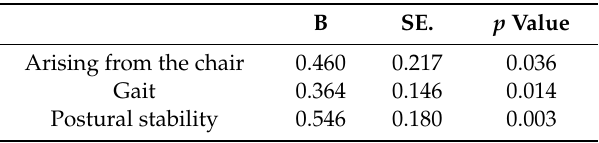
B, coe ffi cient; SE, standardized